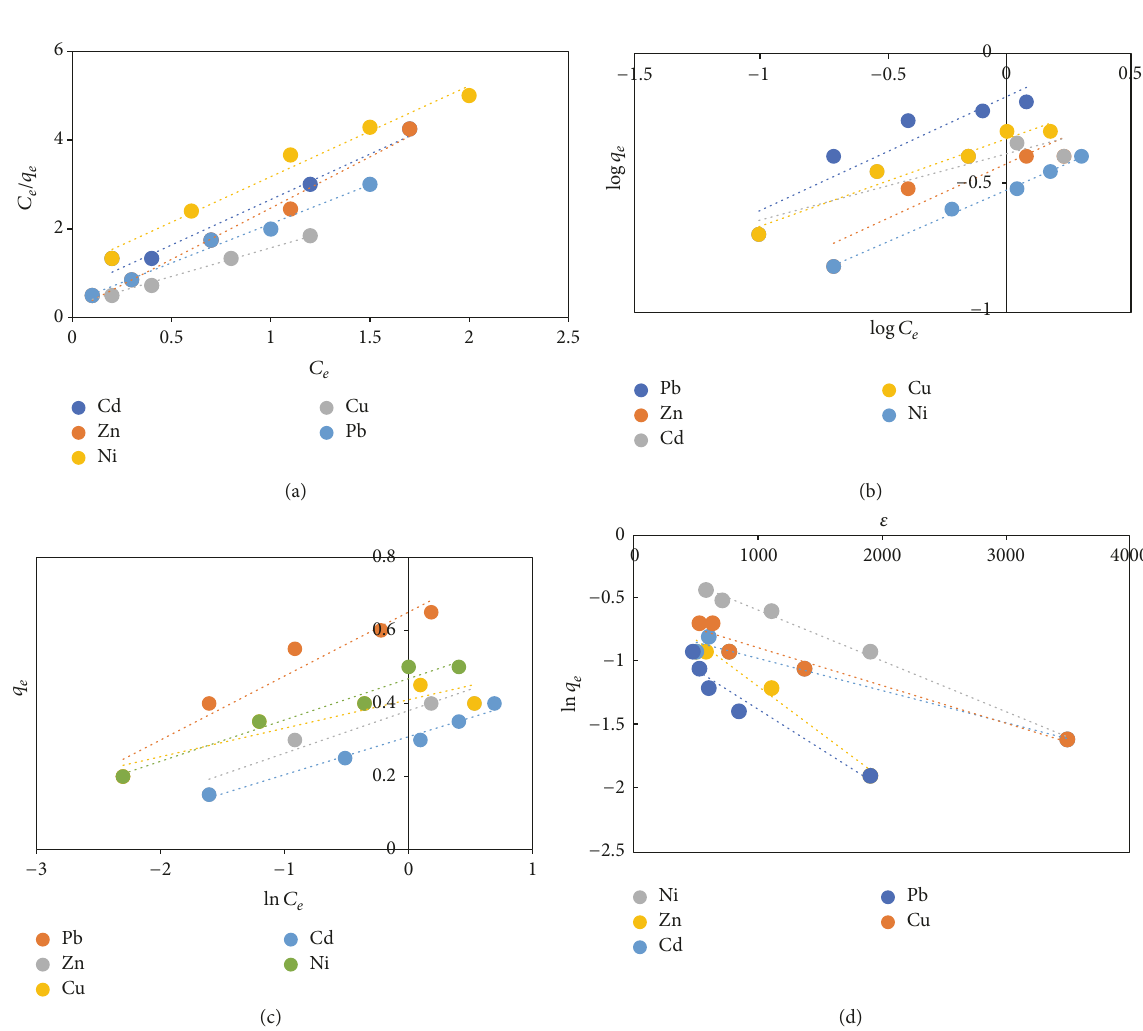
Figure 14: Langmuir, Freundlich, Temkin, and DKR isotherm models, respectively, at temperature of 45 ∘ C. Table 3: Thermodynamic parameters for the adsorption of heavy metal ions onto FGCX at an initial concentration of 0.5mmol/l. Metal ions